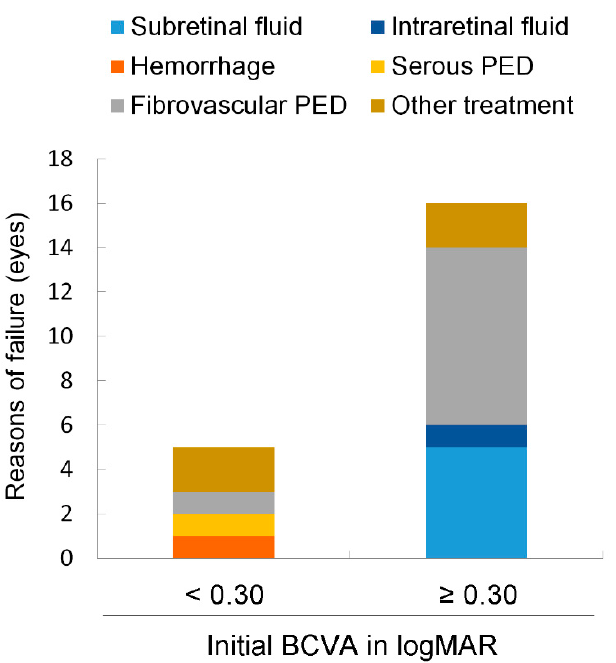
Figure 3. The conditions at the time of failure. Failure of the eyes was determined by a decline of best-correlated visual acuity (BCVA) ≥ 0.2 from the initial BCVA or by the application of treatments other than anti-vascular endothelial growth factor. The numbers of eyes exhibiting fundus findings most likely related to BCVA loss are shown. Two eyes failed owing to other treatment application in both groups, i.e., with or without an initial BCVA < 0.3 in the logarithm of the minimum angle of resolution (logMAR). PED, pigmental epithelium detachment. Table 3. Characteristics of the patients who dropped out before month 36.